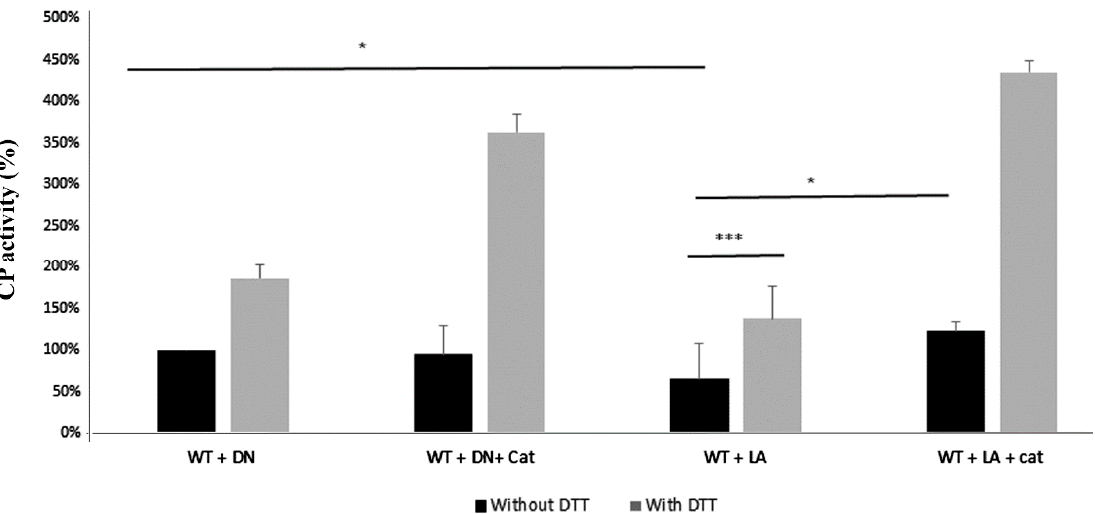
Figure 4. CPs activity of E. histolytica trophozoites. Note: E. histolytica trophozoites were incubated with heat-killed L. acidophilus (DN) or with live L. acidophilus (LA), and with/without catalase (50 μ g/mL) for 2 h at 37 °C. Total protein was prepared and CPs activity was measured. One unit of CP activity was defined as the number of micromoles of substrate digested per minute per milligram of protein. CP activity performed without DTT of E. histolytica trophozoites incubated with heat-killed L. acidophilus (WT + DN) was obtained as 100% and it corresponds to 0.31 units. The data represent two independent experiments performed in triplicate. * p -value < 0.05 by an unpaired Student’s t -test. *** p -value < 0.001 by an unpaired Student’s t -test. 3.4. Adhesion of E. histolytica Trophozoites to HeLa Cells Is Impaired by L. acidophilus